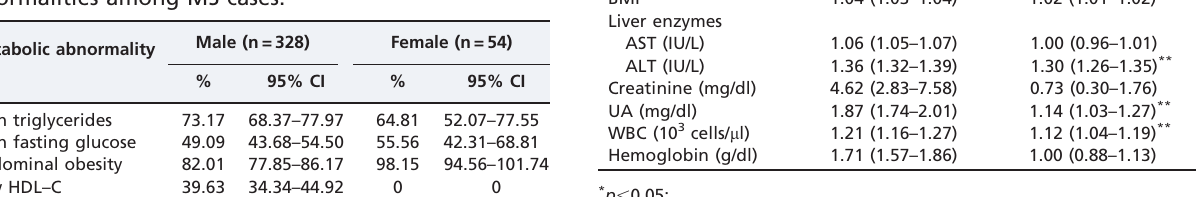
Table 2 - Sex-specific prevalence of individual metabolic abnormalities among MS cases.